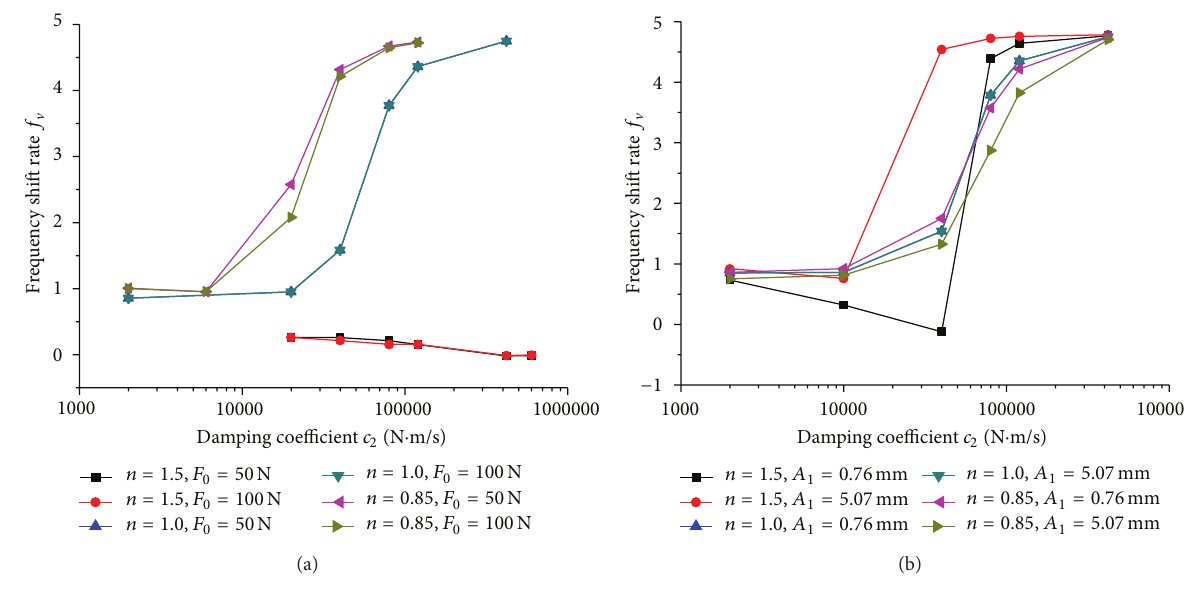
Figure 27: Frequency shift rates of CM. (a) FE cases; (b) FDE